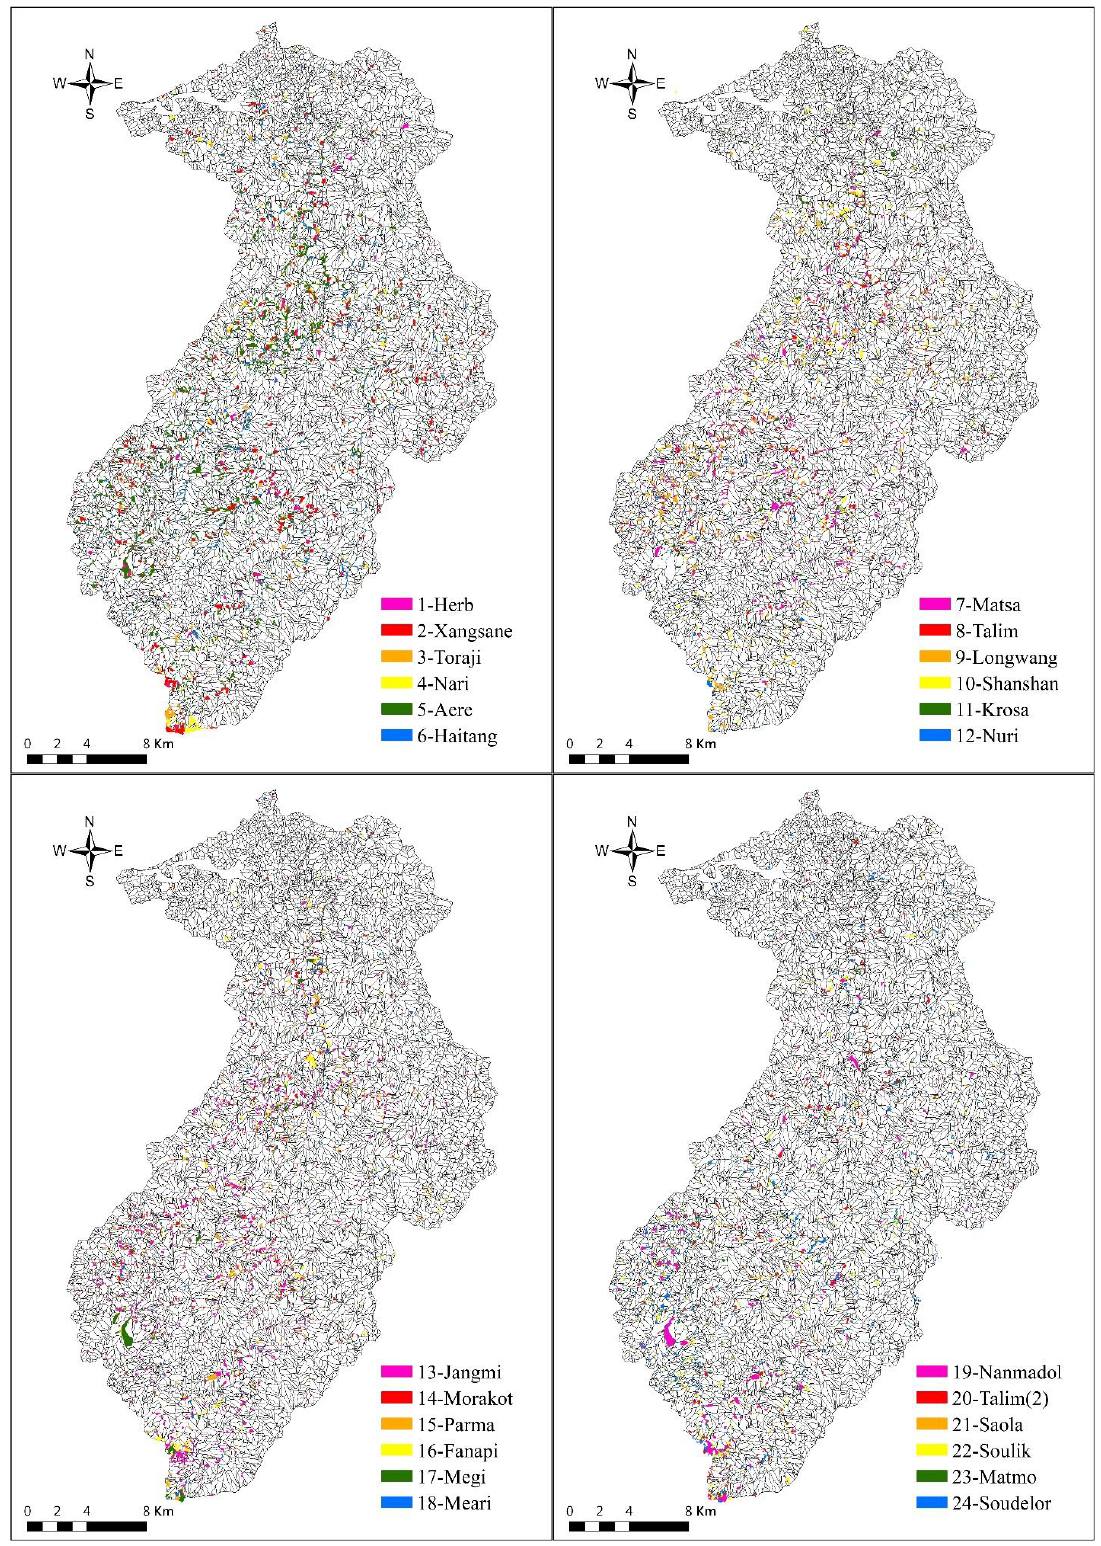
Figure 2. The slope units and landslide inventories, triggered by 24 typhoon events in the Shihmen watershed.